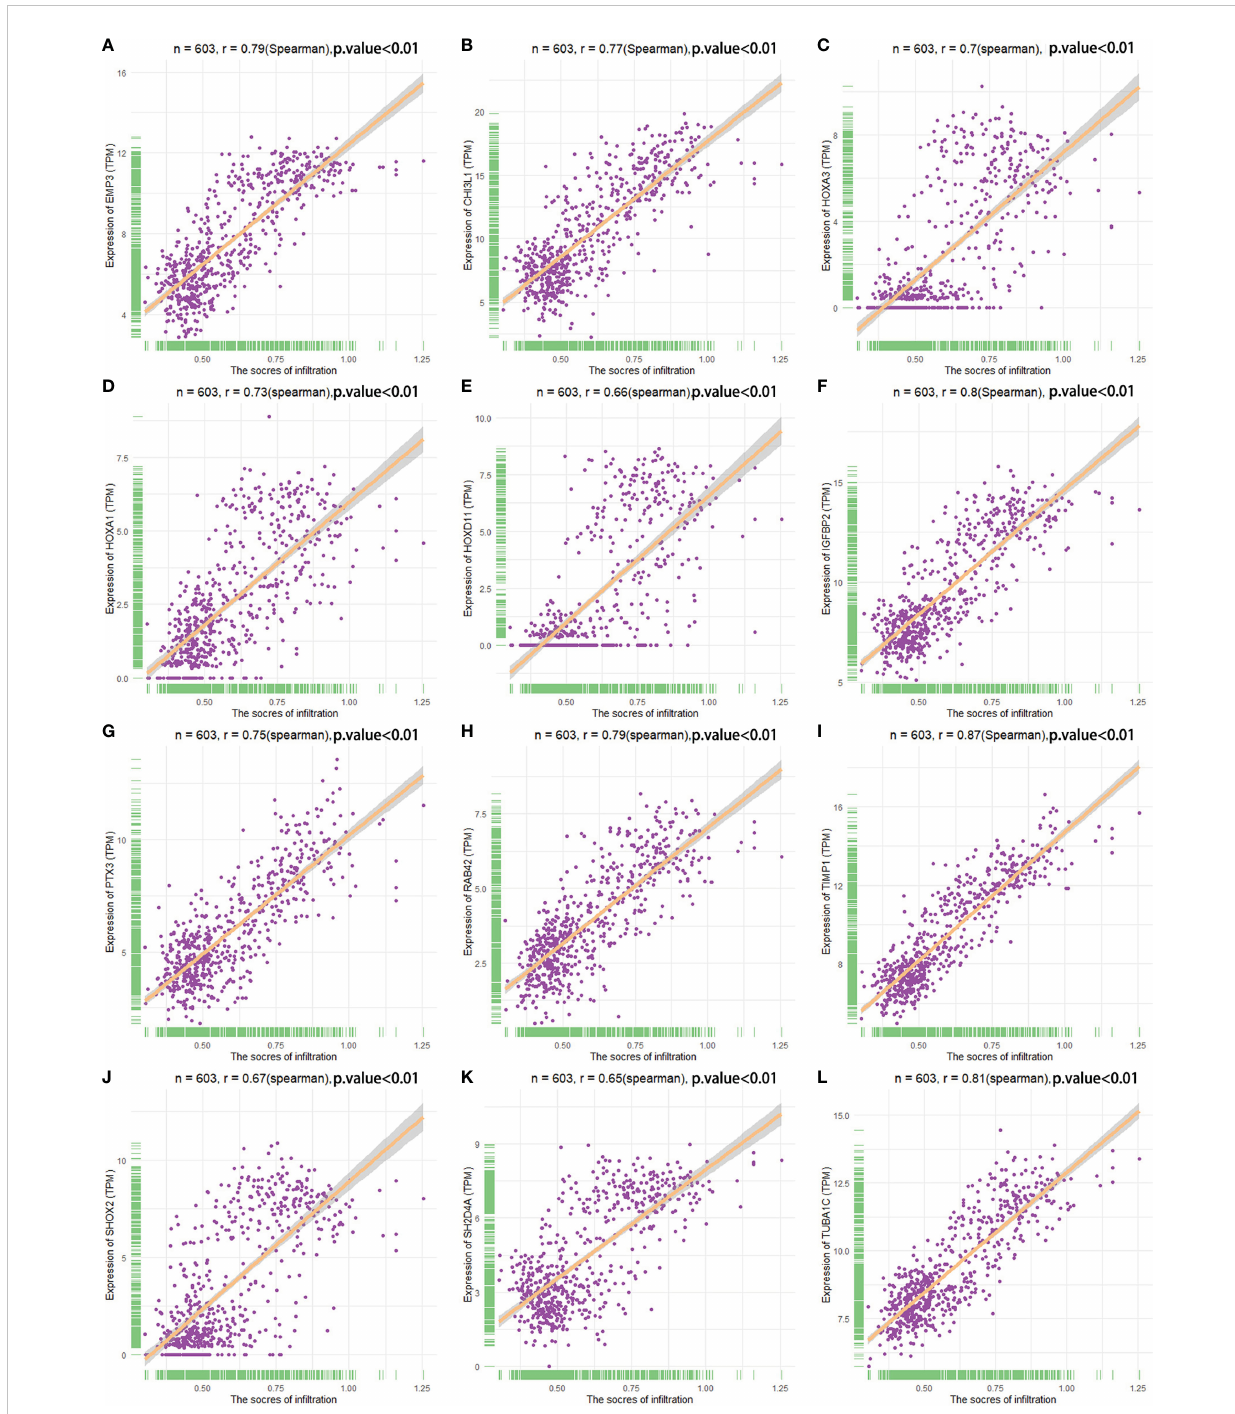
FIGURE 7 Spearman correlation analysis analyzed the correlation between key genes and in fi ltration score. (A – L) The relationship between the key genes and in fi ltration